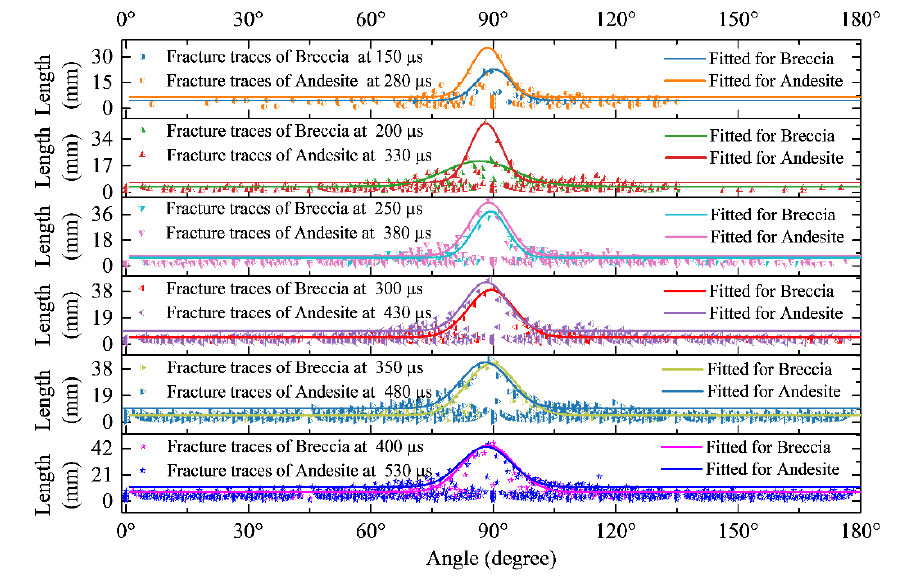
Figure 12. The scatter distribution of lengths at orientations and fitted results by Gaussian function of typical fragmentized processes at different